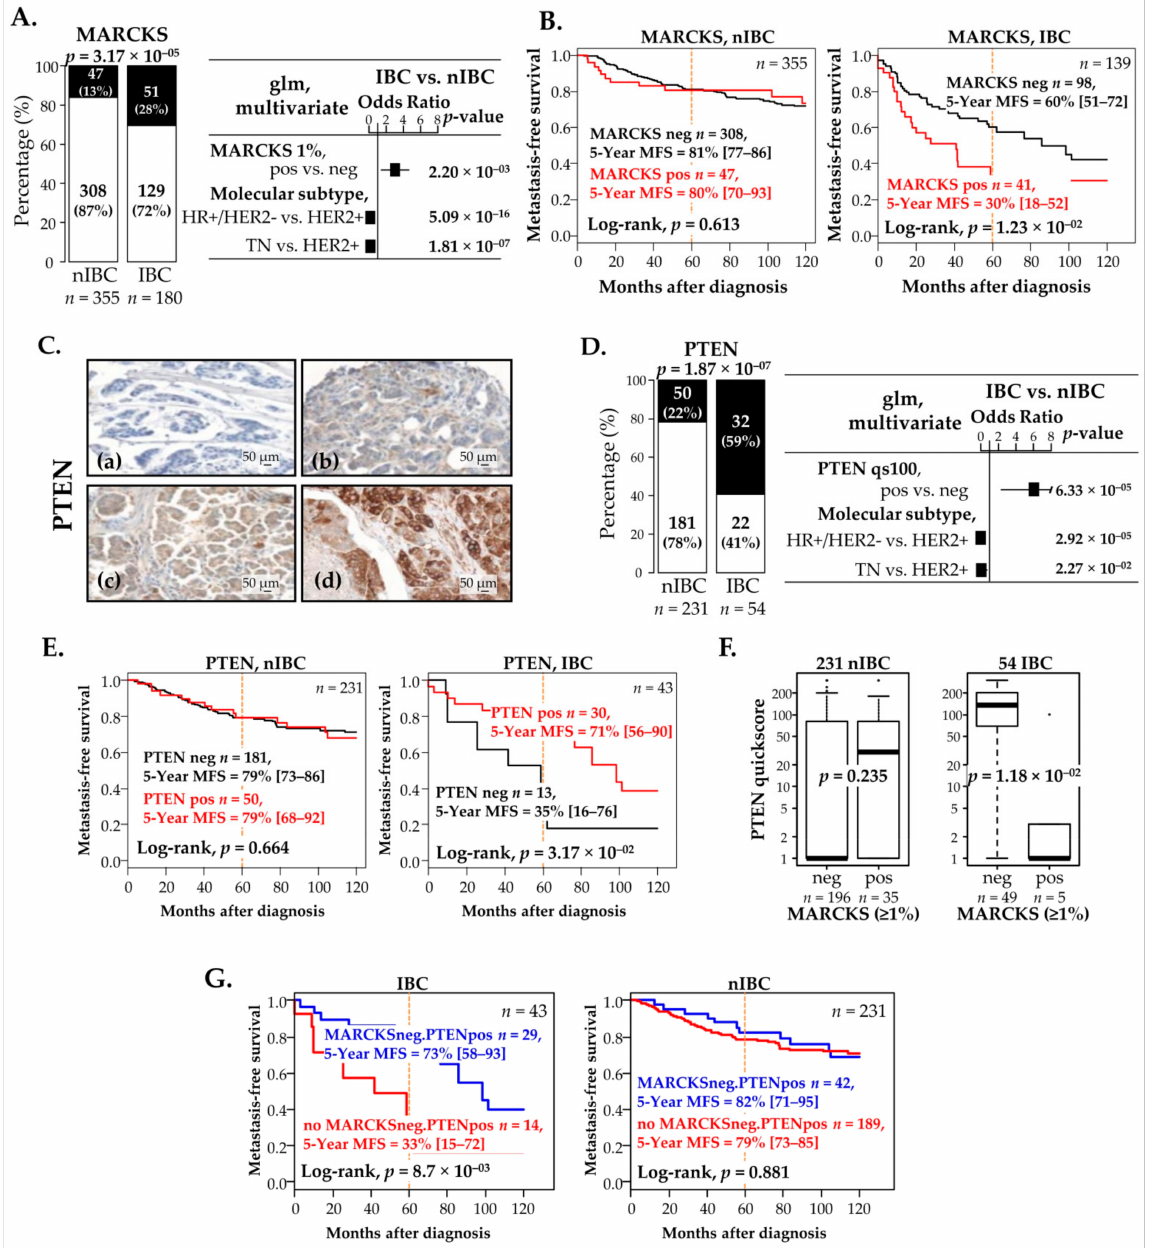
Figure 3. Protein expression of MARCKS and PTEN in IBC and nIBC and prognostic value. ( A ) Left: protein expression of MARCKS in IBC and nIBC patients (white: negative expression; black: positive expression). Right: forest plots showing the Odds Ratio (log10) of MARCKS expression level in IBC vs. nIBC group in a multivariate logistic regression analysis along with molecular subtypes. ( B ) Kaplan-Meier MFS curves in nIBC and IBC patients according to MARCKS expression (black: negative; red: positive). ( C ) Immunohistochemistry staining of PTEN expression in IBC vs. nIBC samples. The illustrated images are represented in; (a) a negative expression, (b) a 20% of staining, (c) 70% of staining, and (d) a 100% of staining: the staining was mainly cytoplasm and some nuclear, and 20 × as magnification. ( D ) Similar to ( A ), but for PTEN expression. ( E ) Similar to ( B ), but for PTEN expression. ( F ) Box plots of PTEN expression (quick score) according to MARCKS expression group in nIBC (left) and IBC (right) samples, showing the negative correlation in IBC only. ( G ) Similar to ( B ) but for the combined expression of MARCKS and PTEN (blue: MARCKS-negative/PTEN-positive; red: no